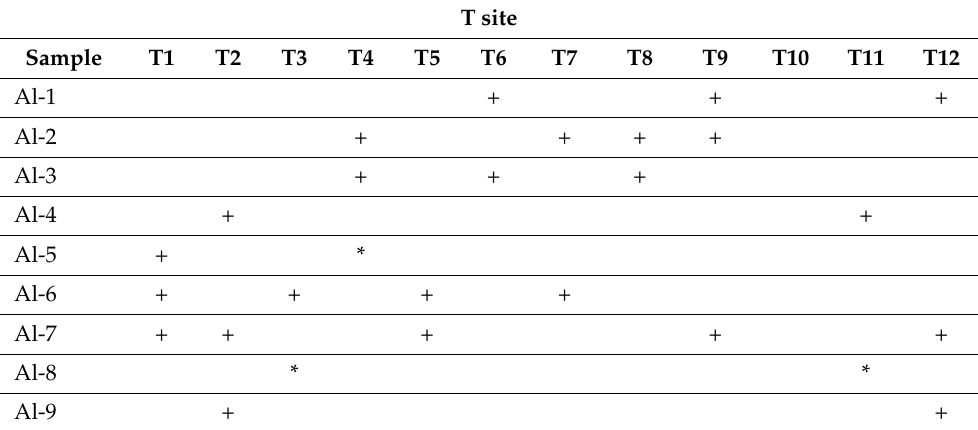
Table 2. Aluminum atoms distribution (* possible presence) over tetrahedral positions (marked with “+”) of orthorhombic